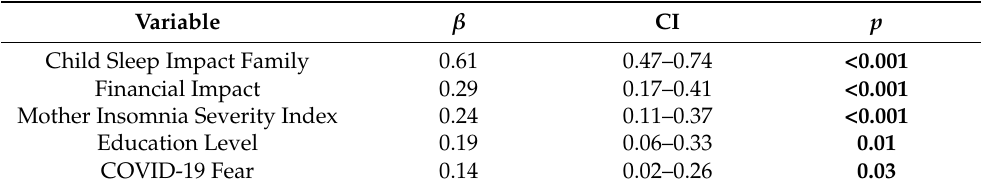
Table 2. Linear multiple regression results for the prediction of child insomnia (DIMS subscale of the SDSC, Swiss